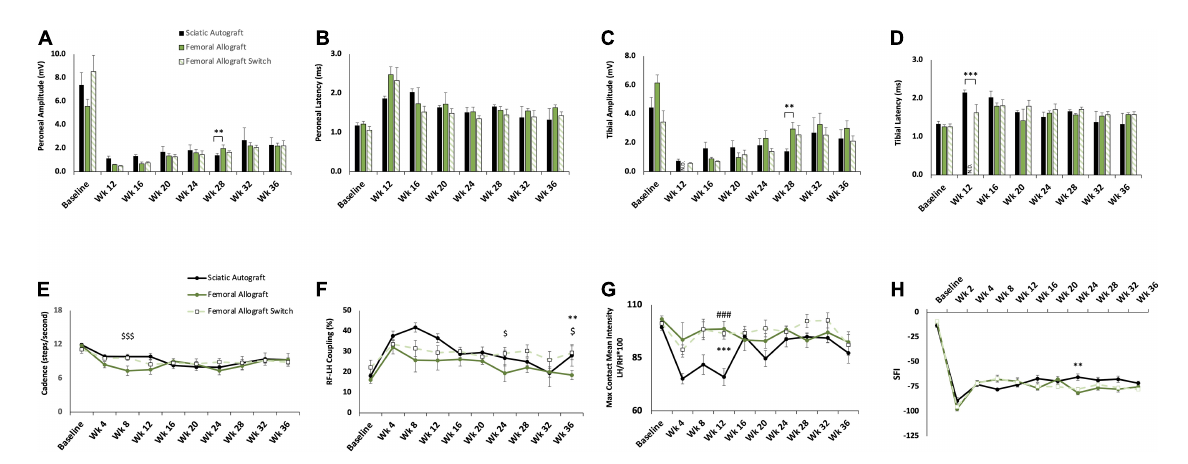
FIGURE7 Compound muscle action potential (CMAP) and gait analysis of inbred Lewis to Lewis femoral allograft and femoral allograft switch groups. Sciatic autograft is included for reference. (A) Amplitude recordings of the peroneal branch of the sciatic nerve. (B) Latency recordings of the peroneal branch of the sciatic nerve. (C) Amplitudes recorded from the tibial branch of the sciatic nerve. (D) Latencies of the tibial branch of the sciatic nerve. ∗∗ p < 0.01, ∗∗∗ p < 0.001, N.D. indicates fewer than 3 rats responded. (E) Cadence in steps per second as calculated by the CatWalk software. (F) RF-LH coupling showing the percentage of time the left hind (LH) paw preceded the right front (RF) paw in the step pattern. (G) Measure of the maximum intensity at the point of maximum contact for the left hind paw/right hind paw*100. (H) Sciatic functional index (SFI) recordings as calculated by the CatWalk software. n = 5 for autograft group and n = 6 for inbred femoral allografts in both orientations. ∗∗ p < 0.01, ∗∗∗ p < 0.001 between sciatic autograft and femoral allograft, ### p < 0.001 between sciatic autograft and femoral allograft switch, $ p < 0.05, $$$ p < 0.001 between femoral allograft and femoral allograft switch. All statistical analysis are a repeated measures ANOVA with Tukey post hoc test. Error bars are